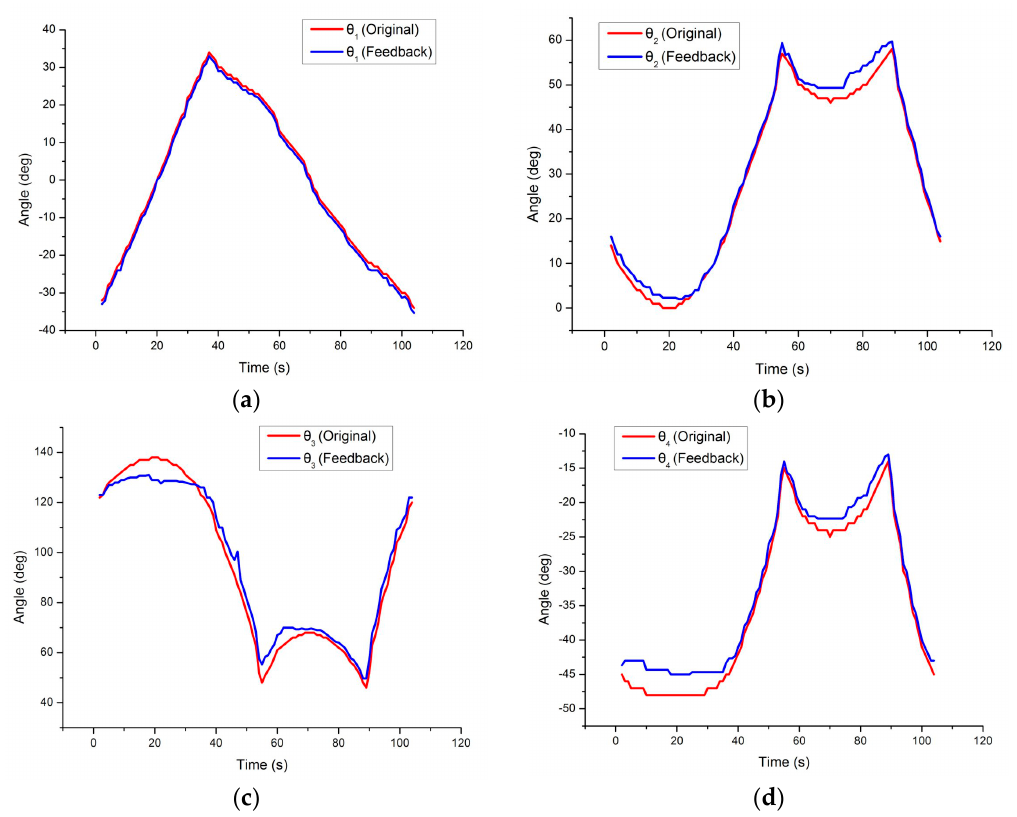
Figure 9. The theoretical and measured angular changes in each axis of the robot arm carrying an object and moving along a given rectangular path: ( a ) Axis-0 ( θ 1 ); ( b ) Axis-1 ( θ 2 ); ( c ) Axis-2 ( θ 3 ); ( d ) Axis-3 ( θ 4 ).